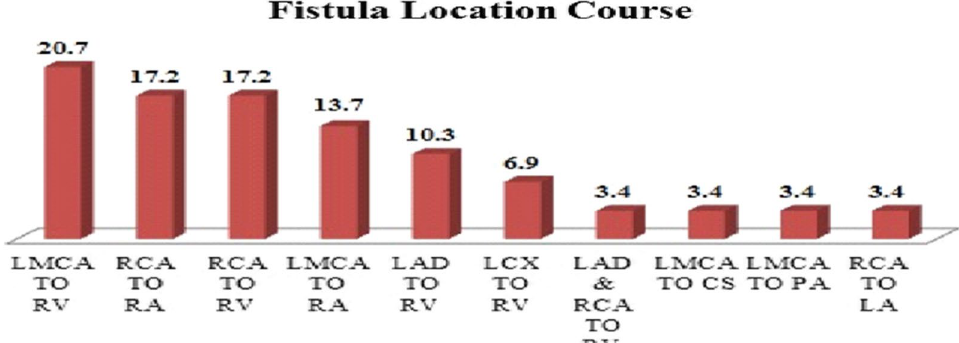
Fig. 3 Different coronary artery fistula drainage sites in patients suffering coronary artery